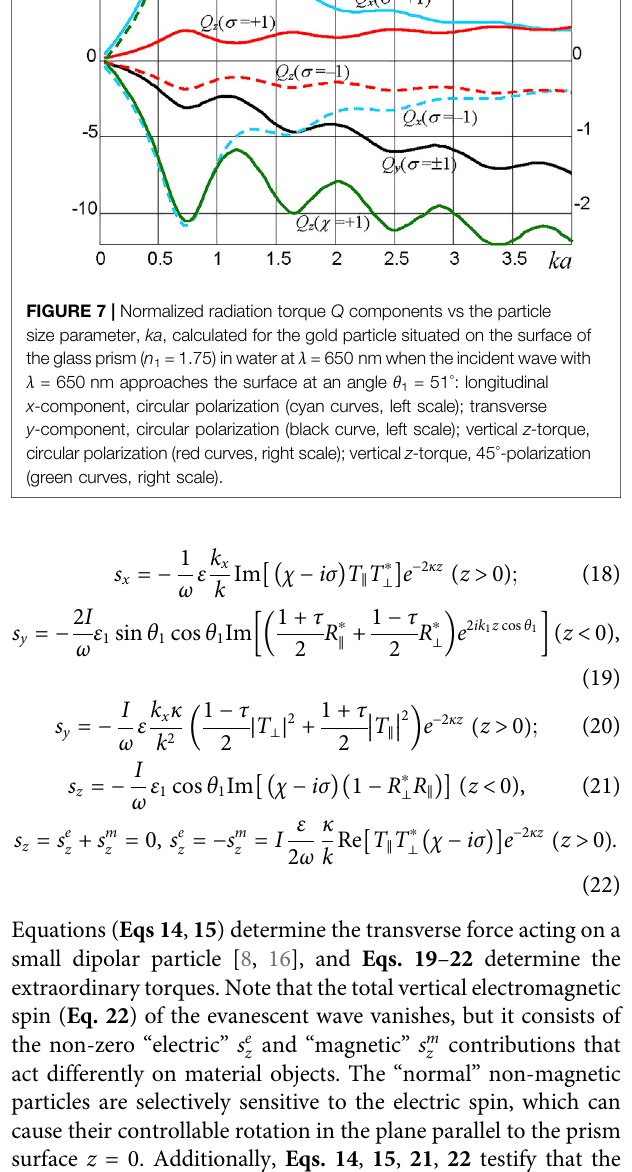
Frontiers in Physics |